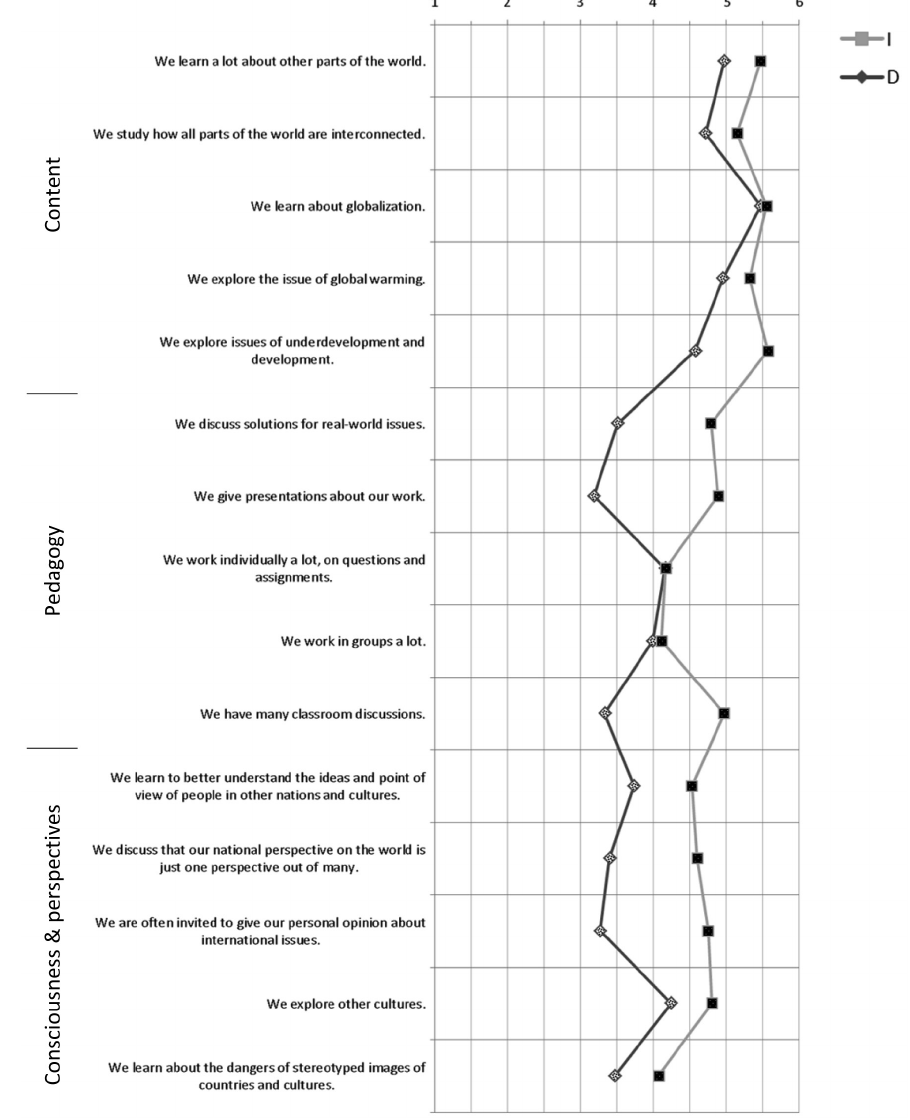
Figure 3: Responses of students from regular (D) and